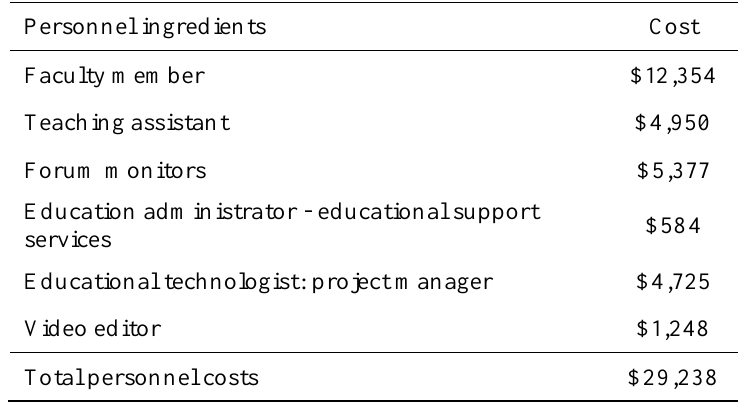
Personnel Costs for Big Data in Education Development and Delivery Personnel